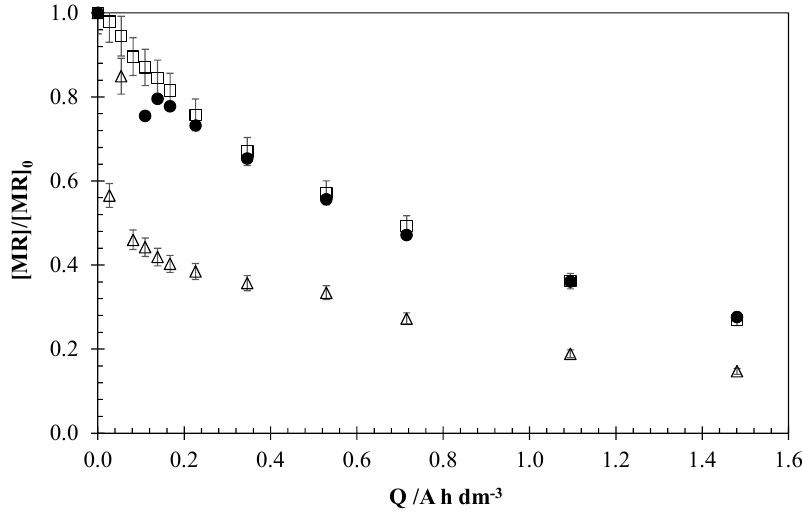
Figure 2. Influence of the initial concentration of the pollutant on the Electrochemical Oxidation (EO) of methyl red (MR). Operation conditions: 15 mA cm − 2 , 0.051 M NaCl. ( □ ) 5 mg dm − 3 ; ( ● ) 2.5 mg dm − 3 ; ( ∆ ) 1 mg dm − 3 .